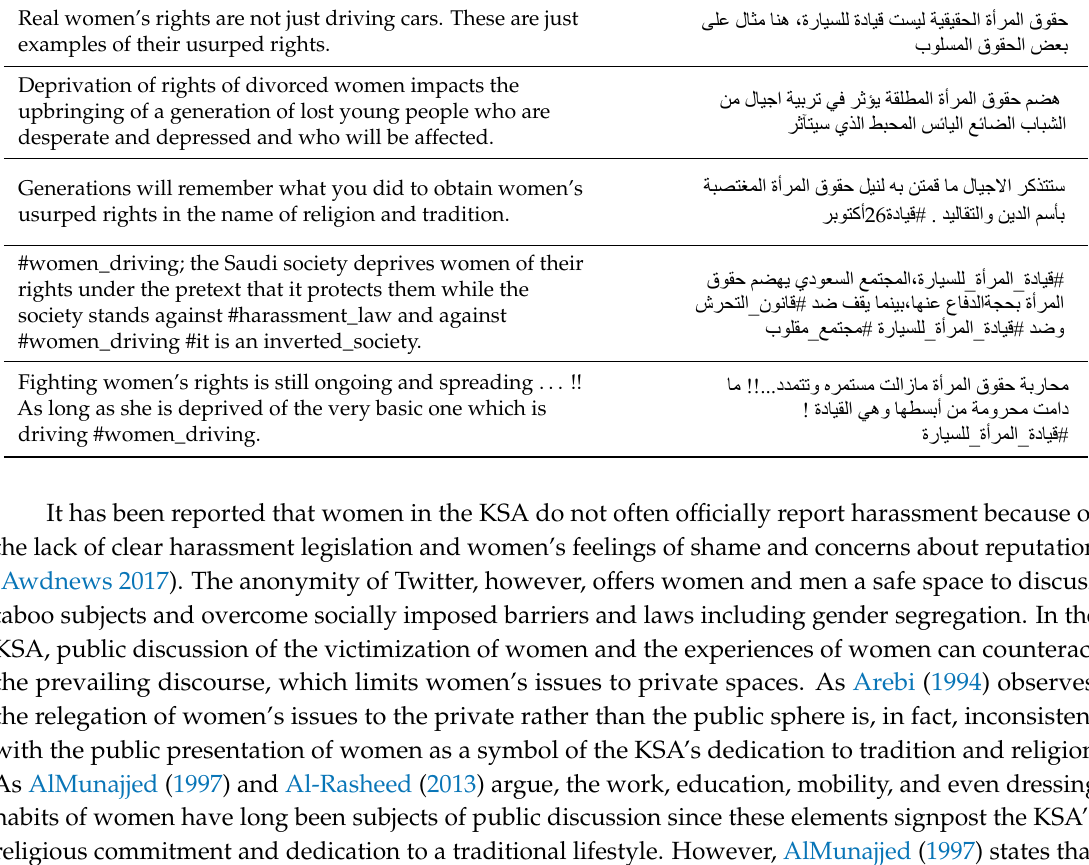
Translation into English Examples in Arabic